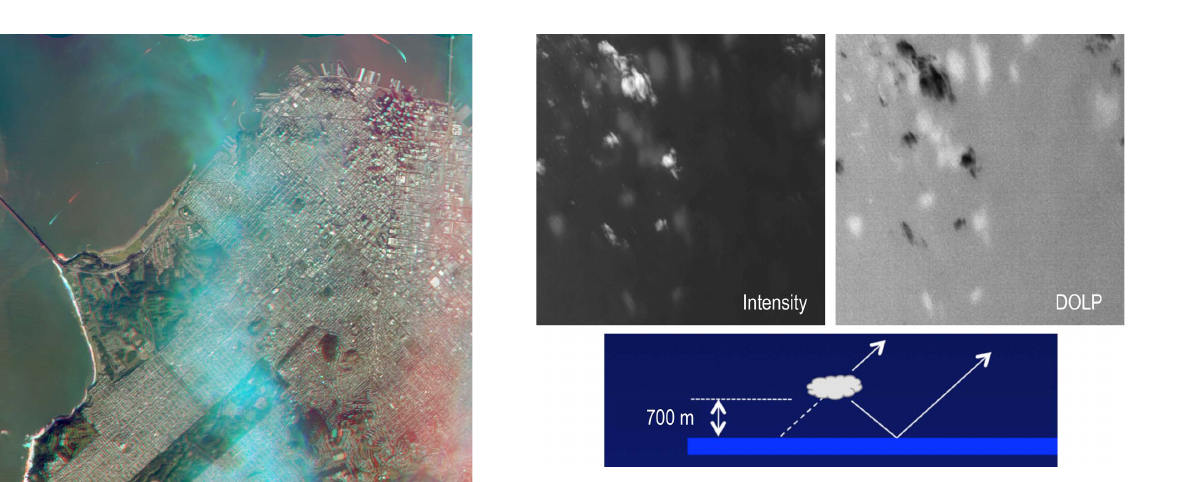
Fig. 17. Top left panel: 46 ◦ forward view of 865nm intensity show- ing clouds and cloud reflections in the ocean, acquired 7 Octo- ber 2010. Top right panel: same view in DOLP. The clouds appear dark in polarization at this illumination and view geometry, but the cloud reflections in the water are highly polarized. Bottom panel: cartoon of cloud reflection in water and geometrically derived base height of ∼